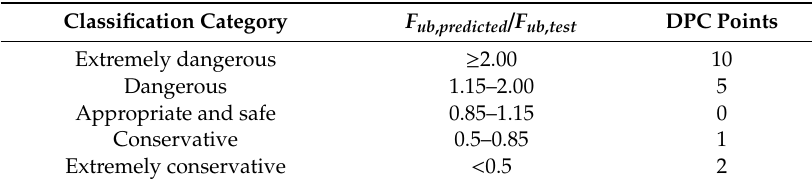
Table 8. The demerit points classification (DPC) scale.